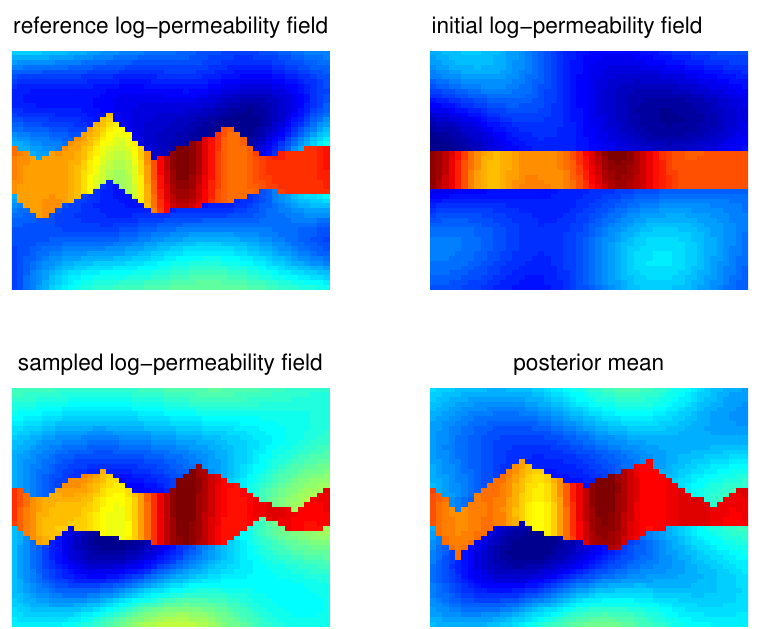
Figure 7. Top left : The true log-permeability field. Top right : Initial log-permeability field. Bottom left : One of the sampled log-permeability field. Bottom Right : The mean of the sampled log- permeability field from two-stage MCMC using 20 K-L terms.